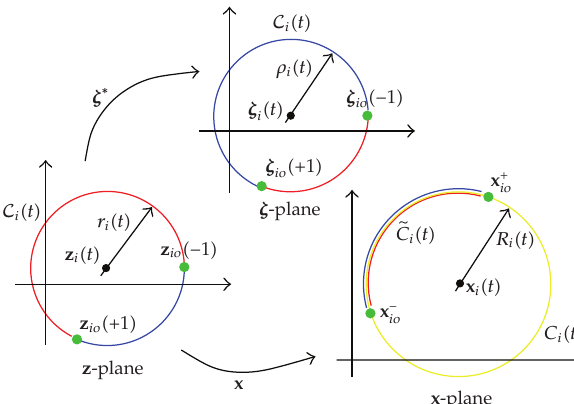
(cid:22) C i (cid:2) t (cid:3) in the are represented with green dots. The same colours io